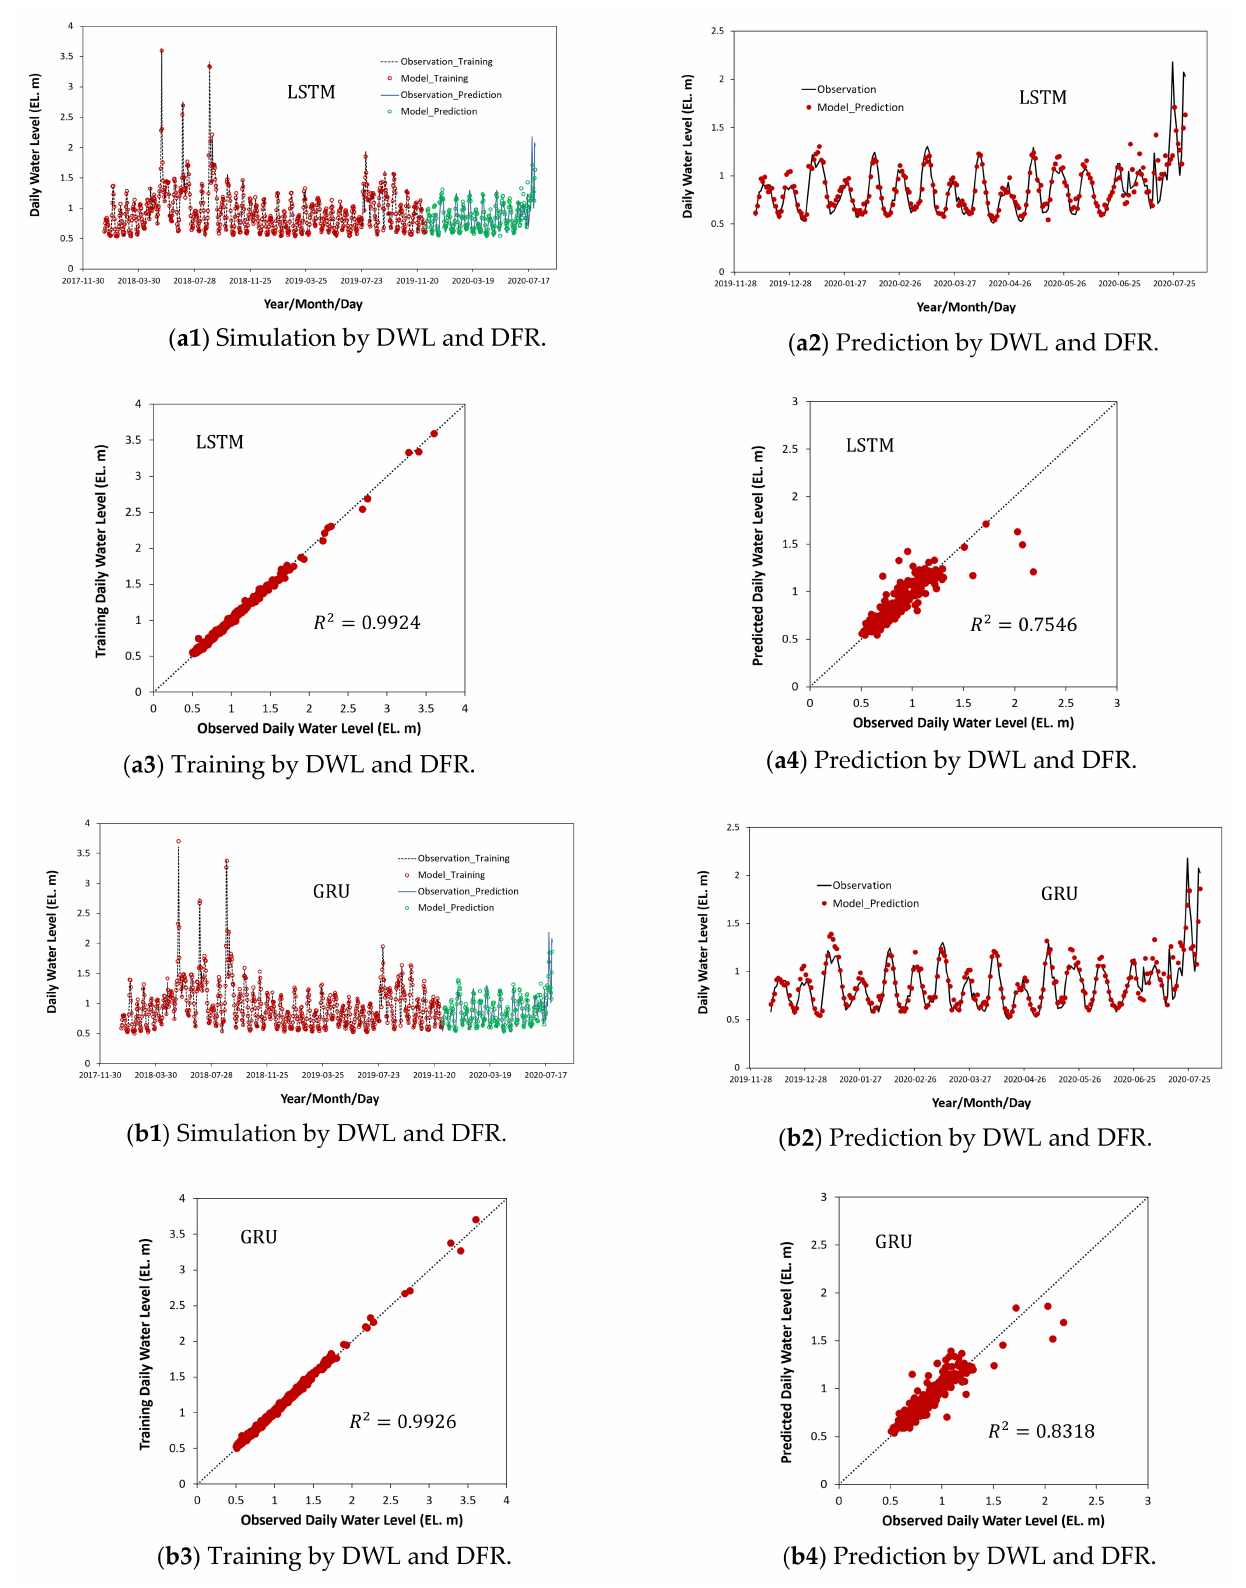
Figure 7. Observed and computed total time series water levels ( a1 ) and ( b1 ) as bivariate input data, prediction ( a2 ) and ( b2 ) as bivariate input data, R 2 for training ( a3 ) and ( b3 ), and R 2 for prediction ( a3 ) and ( b3 ): ( a1 – a4 ) LSTM; and ( b1 – b4 )